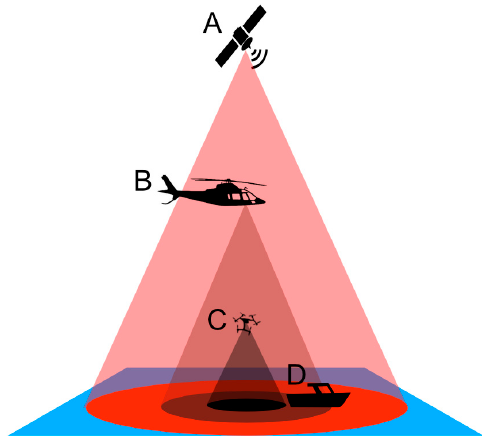
Figure 1. Illustration of the hierarchical monitoring program using ( A ) satellite, ( B ) helicopter, ( C ) drone and ( D ) field boat to study the mixing of channel plumes in the coastal zone.